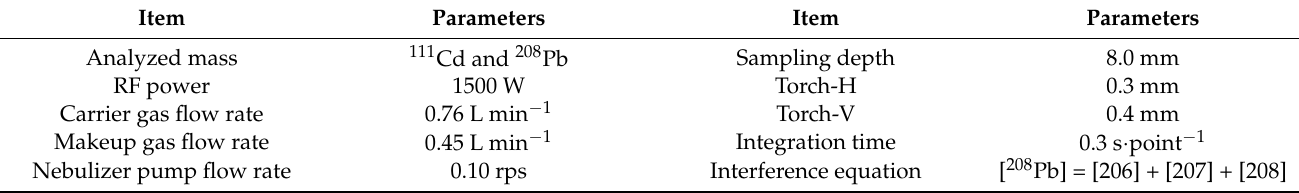
Table 9. Instrumental operating conditions for